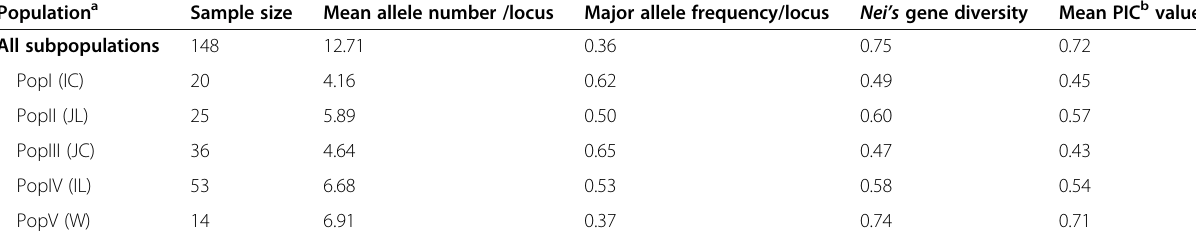
Table 2 Genetic diversity parameters of five subpopulations Population a Sample size Mean allele number /locus Major allele frequency/locus Nei ’ s gene diversity All subpopulations